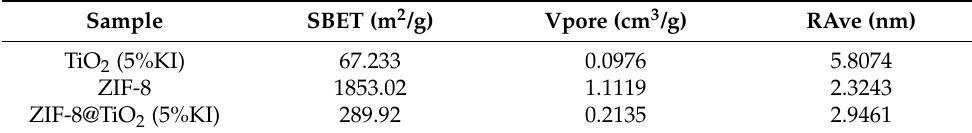
Table 2. Specific surface area and pore size of TiO 2 (5%KI), ZIF-8, ZIF-8@TiO 2 (5%KI).